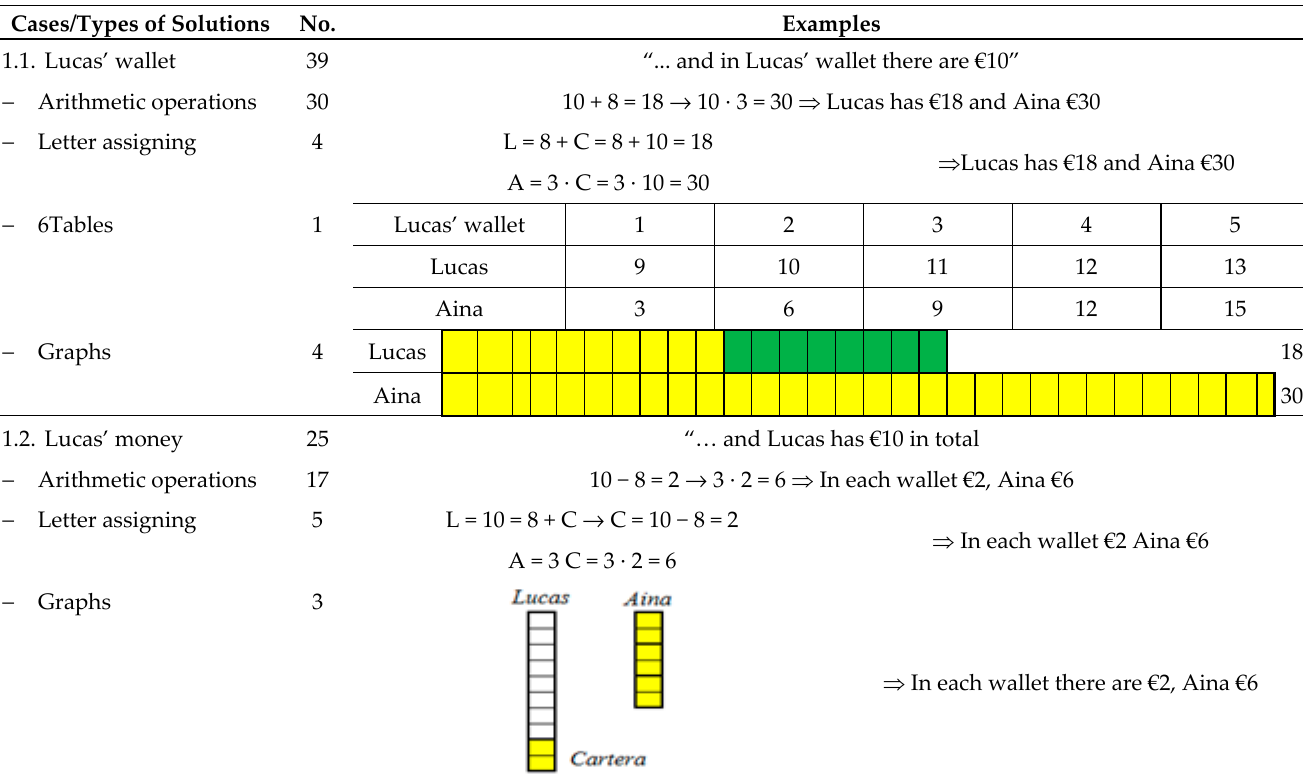
Table 5. Tasks posed and types of solutions in case 2.